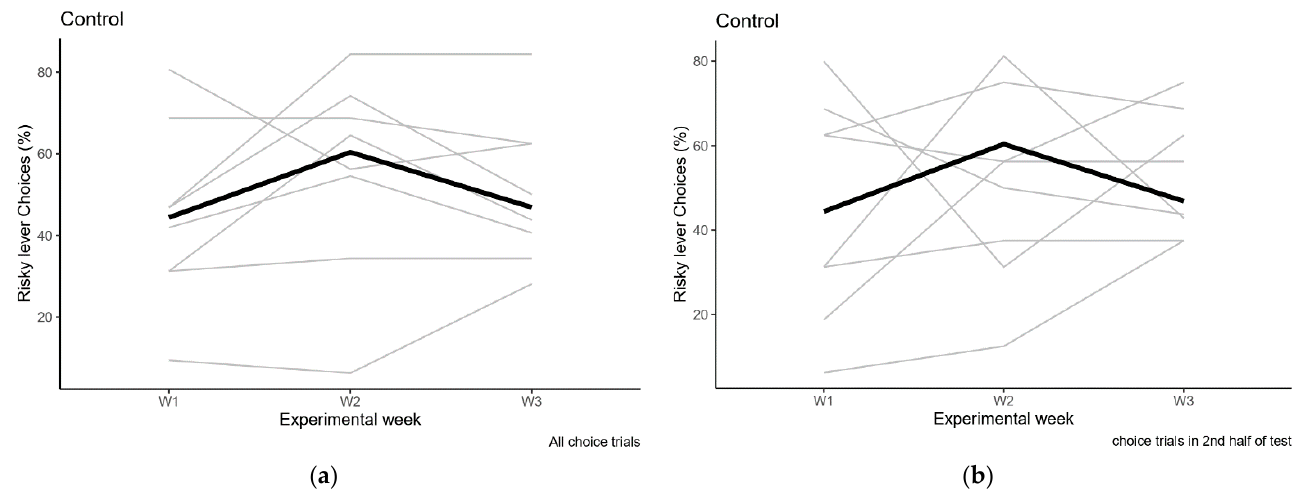
Figure 6. Risk preference in the control condition for sleep deprivation. ( a ) Preference in the completed choice trials from the entire session; ( b ) Preference in the completed choice trials from the second half of the session. Individual data in grey, median values in black. W1: baseline, W2: control housing in the SDDs, W3: recovery.